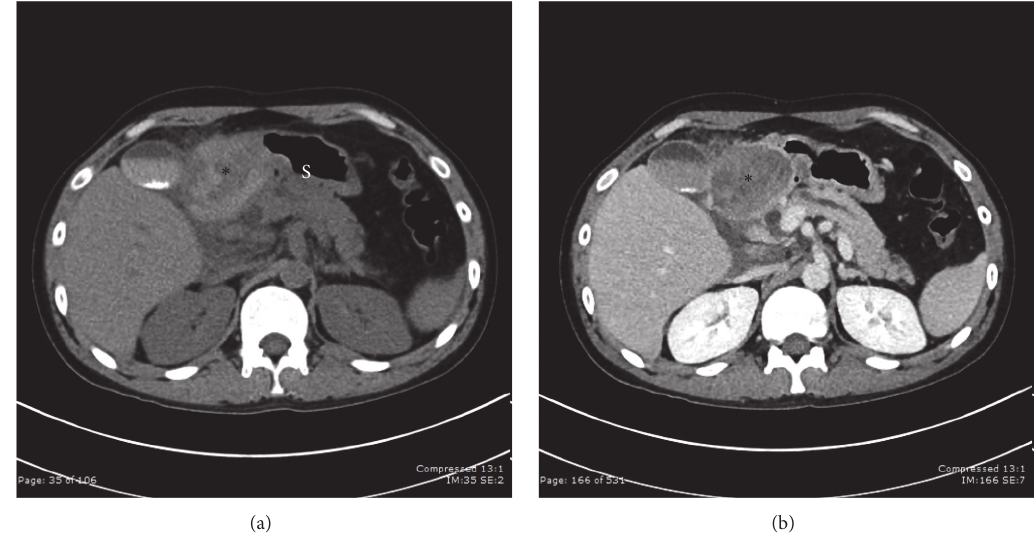
Figure 1: (a) Noncontrast CT scan shows a heterogeneously high-attenuation mass ( ∗ ) along the course of 1st, 2nd, and 3rd part of duodenum, which is compatible with duodenal hematoma. Note the surrounding fat stranding. S = stomach. (b) Contrast-enhanced CT shows the lack of enhancement within the mass (asterisk). Note the displacement of gas in gastric lumen secondary to mass.